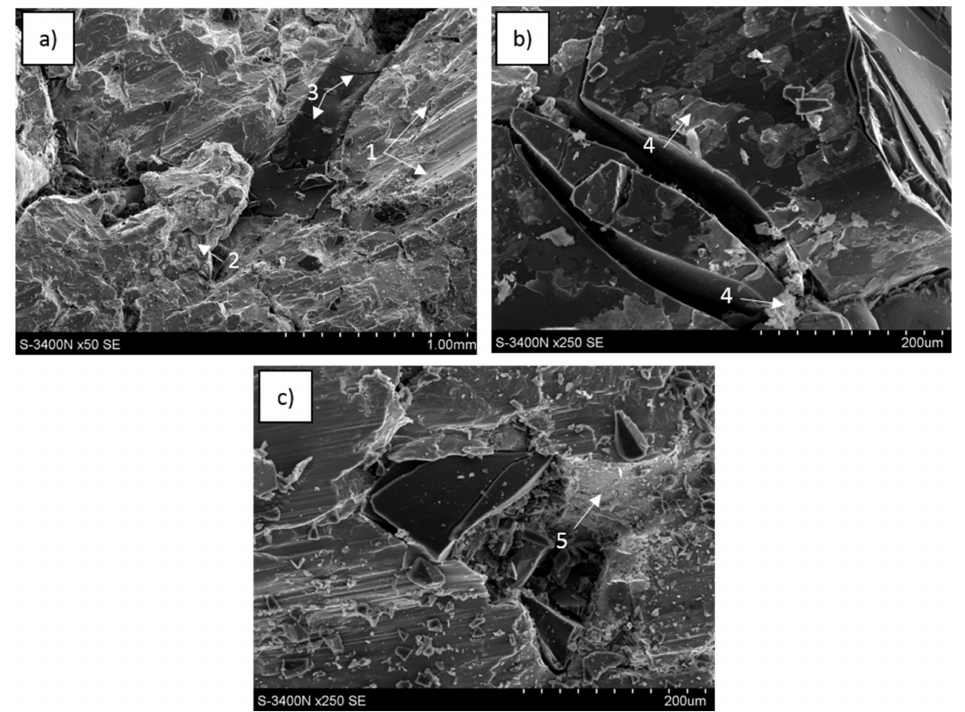
Figure 11. SEM images of C of 20ppi–RZ5 composite fractured during compression strength testing: ( a ) metal matrix with di ff erent oriented shear bands (1) and dendrites (2), carbon foam fractured across the wall (3), ( b ) cracked carbon foam delaminated from the matrix and coated with irregular phases (4), ( c ) cracked and refined foam in the matrix with shear bands, matrix delaminated from foam (5) coated with fine and cracked phases.